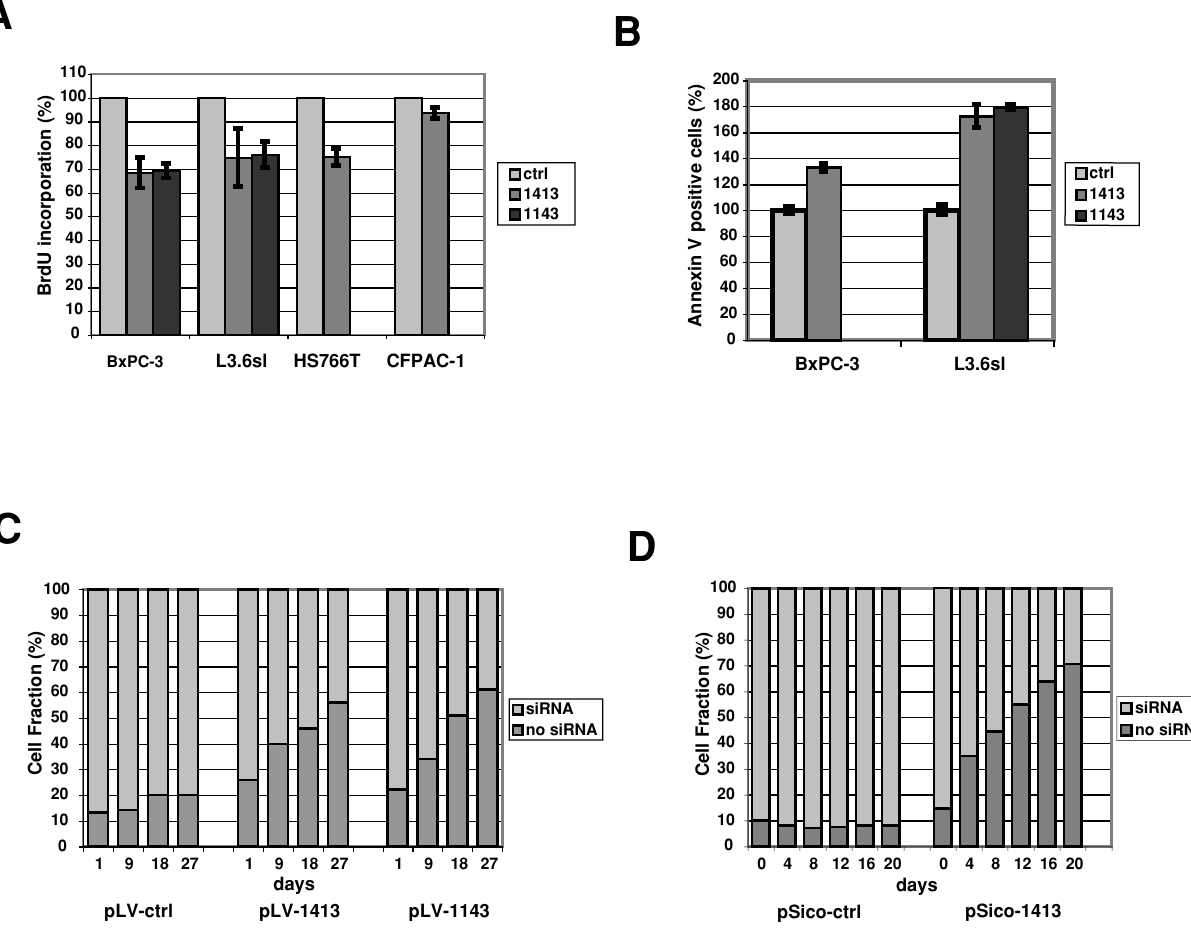
Figure 5. The effects of Sulf-2 siRNAs on proliferation, apoptosis, and growth of pancreatic cancer cells. A: The indicated cells were transduced with control (pLV-ctrl) or Sulf-2 shRNA (pLV-1413, pLV-1143). The cells were then incubated with BrdU for one hour and BrdU incorporation was detected by flow cytometry analysis. The values shown are the mean + /- SD’s for 2 independent experiments. The differences in BrdU uptake between ctrl and Sulf-2 silenced cells were statistically significant for BxPC-3 (p , 0.005), L3.6sl (p , 0.007) and HS766T (p , 0.001). B: BxPC-3 and L3.6sl pancreatic cells were transduced with control (pLV-ctrl) or Sulf-2 shRNA (pLV-1413, pLV-1143) were harvested and incubated with PE-conjugated annexin V. Subsequently cells were subjected to flow cytometry analysis. The differences between between ctrl and Sulf-2 silenced cells were statistically significant with p-values of 0.0001 for BxPC-3 and p , 0.004 for L3.6sl. C and D: L3.6sl cells were transduced with either pLV-1413, pLV- 1143 or pLV-ctrl and mixed populations of siRNA and non-siRNA expressing cells were co-cultured. Ratios of transduced to non-transduced cells were measured over time by GFP expression. BxPC-3 cells were transduced with either pSico-ctrl or pSico-1413 and transiently transfected with cre- recombinase to activate expression of the shRNA. The resulting mixed populations of cells with activated (GFP-) and inactivated (GFP + ) shRNA expression were co-cultured. Ratios of GFP + to GFP- cells, using flow cytometry were analyzed as a function of time. Expression of GFP did not have any effect on cell growth in the control